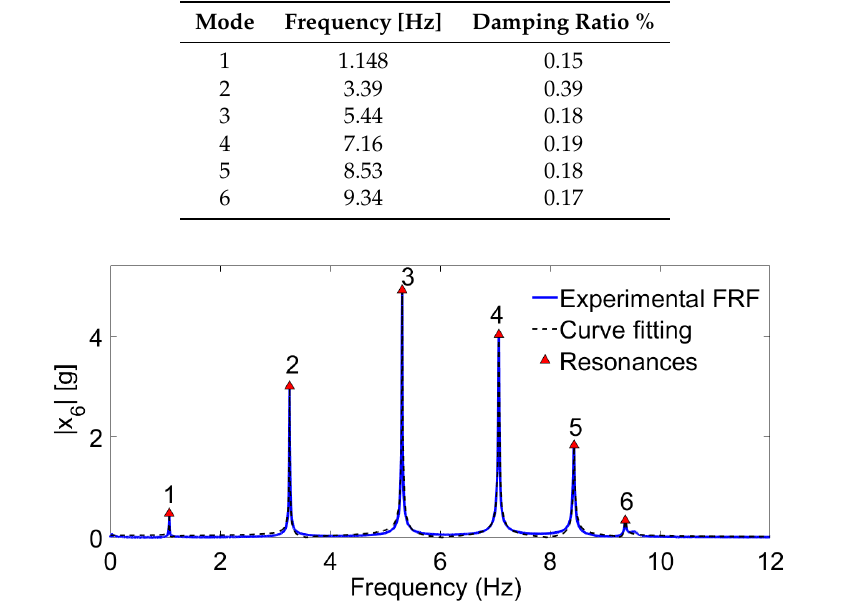
Table 1. Modal parameters of the six-story building-like structure.